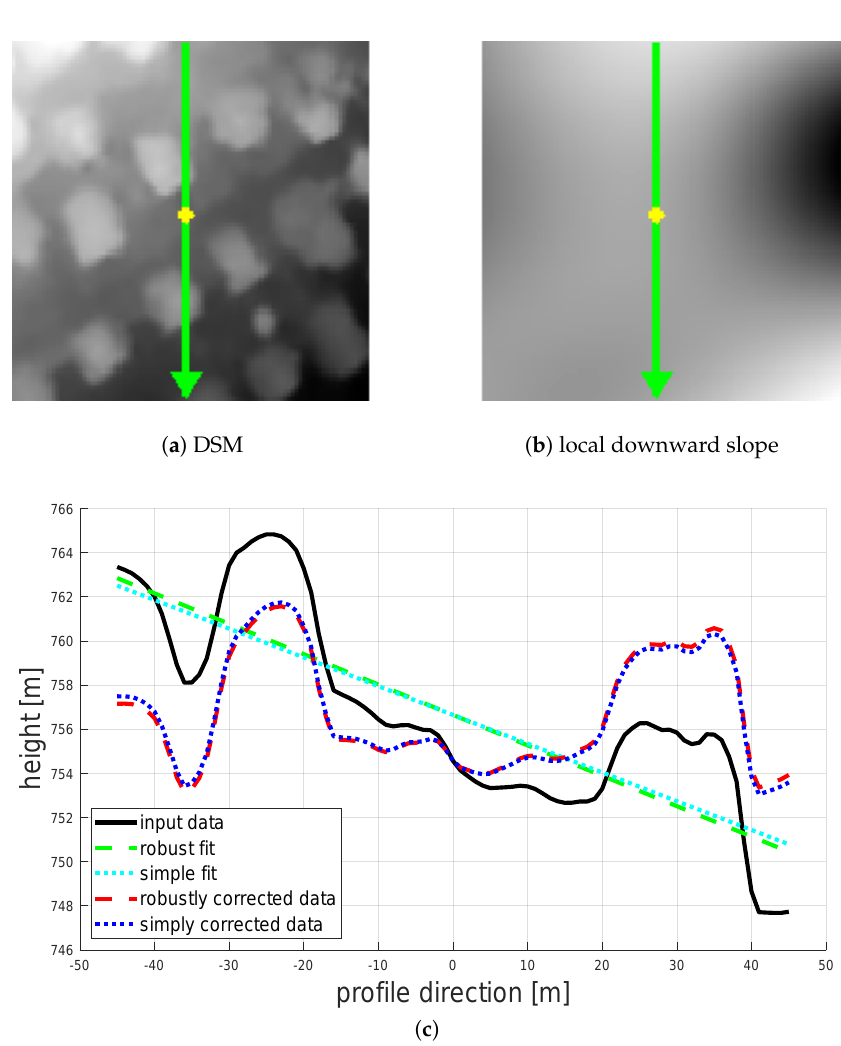
Figure 15. Comparison of robust terrain slope fit to the proposed simple fit. ( a ) shows a subset of a DSM and ( b ) its Gaussian filtered variant. ( c ) visualizes the profile of the DSM along the green arrow together with the terrain slope fits and the corrected profiles.